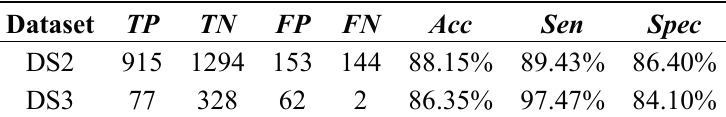
Table 12. Evaluation results: Activity classification.